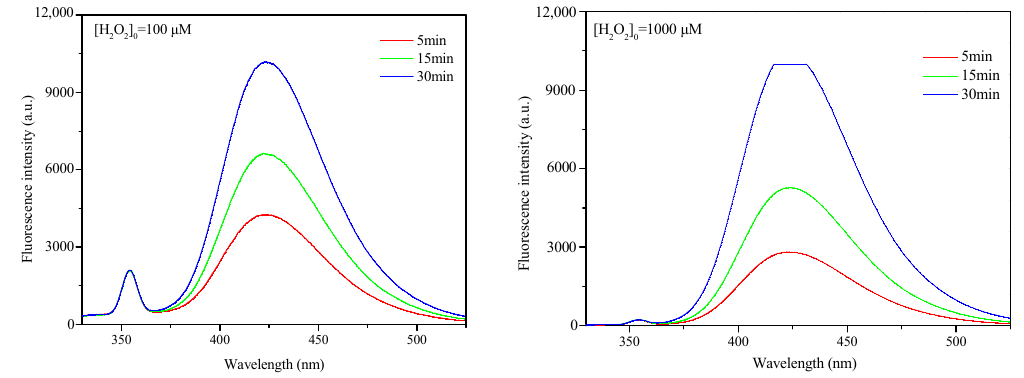
Figure 3. Photoluminescence (PL) spectral changes observed in the UV / H 2 O 2 system in a 5 × 10 − 4 M basic solution of terephthalic acid (excitation at 315